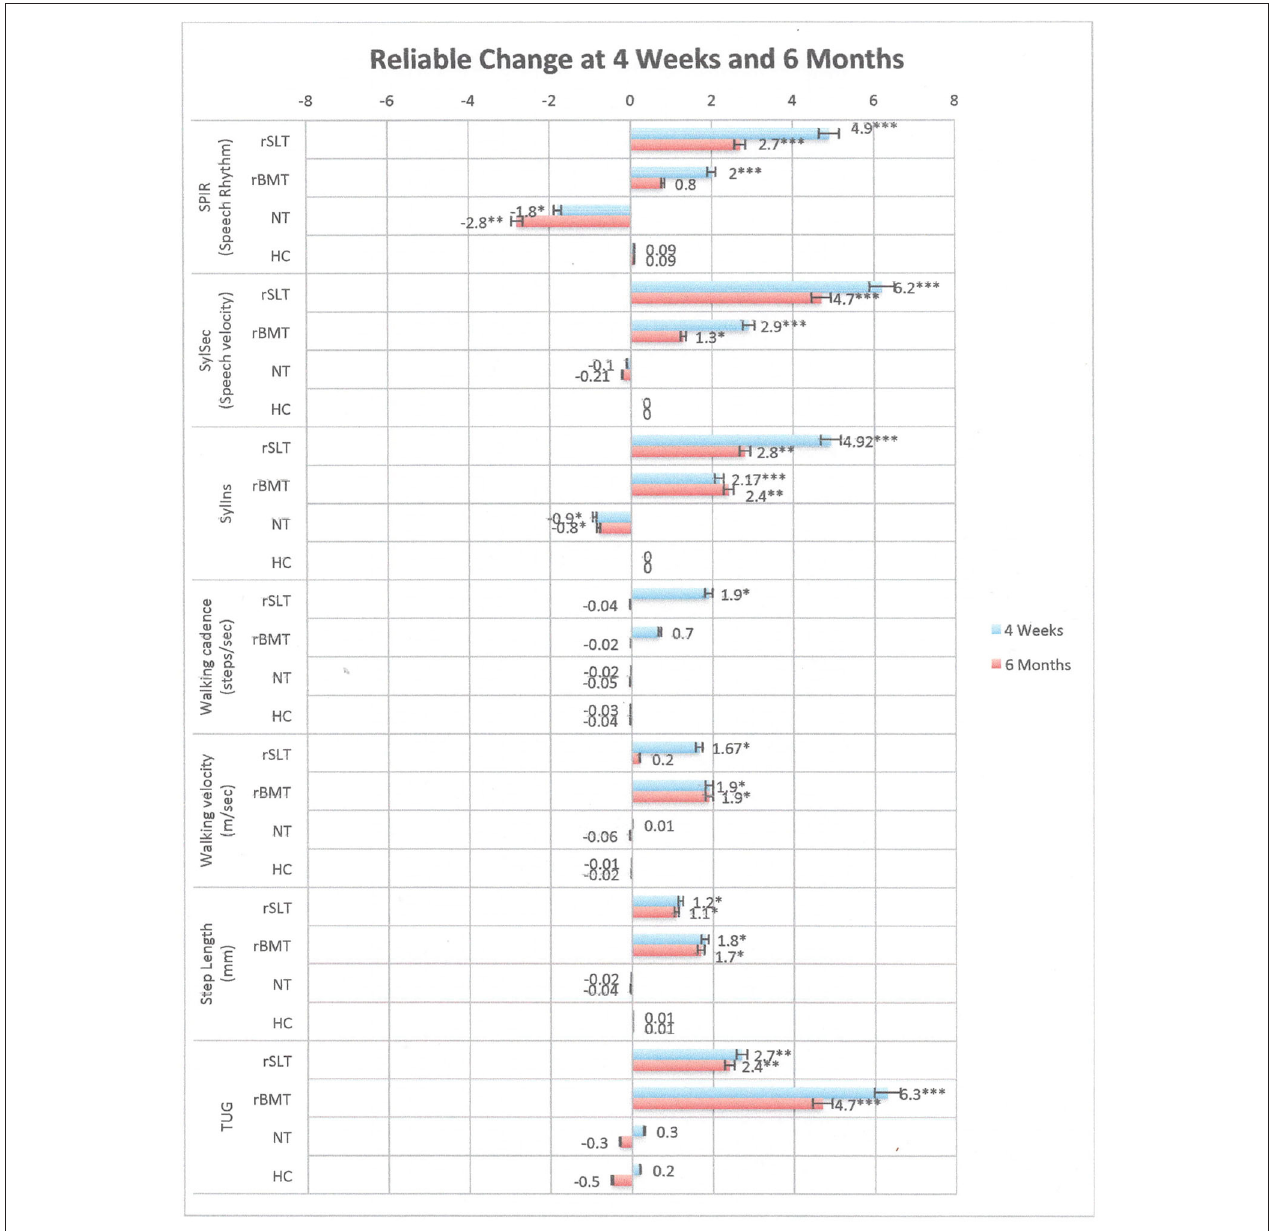
FIGURE 3 | Performances of all groups across variables and time. Bars indicate Reliable change scores (Mn; SD) in performance when comparing 4 weeks to BL, and respectively, 6 months to BL. Positive scores indicate improvement, negative scores indicate a decline. Numbers marked with an asterisk are significant as follows *** p < 0.001; ** p < 0.01; * p < 0.05.